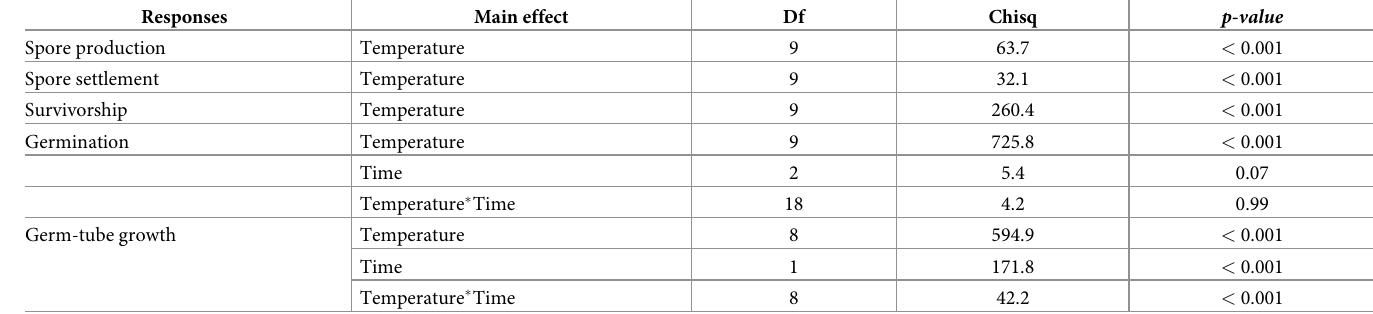
Table 1. Information of fitted models using a linear mixed-effects modelling (LLM) with a Gaussian family and identity link. Temperature and time (experimental duration, in day) were fitted as fixed effects, and individual was random effect. Statistical significance at p-value <